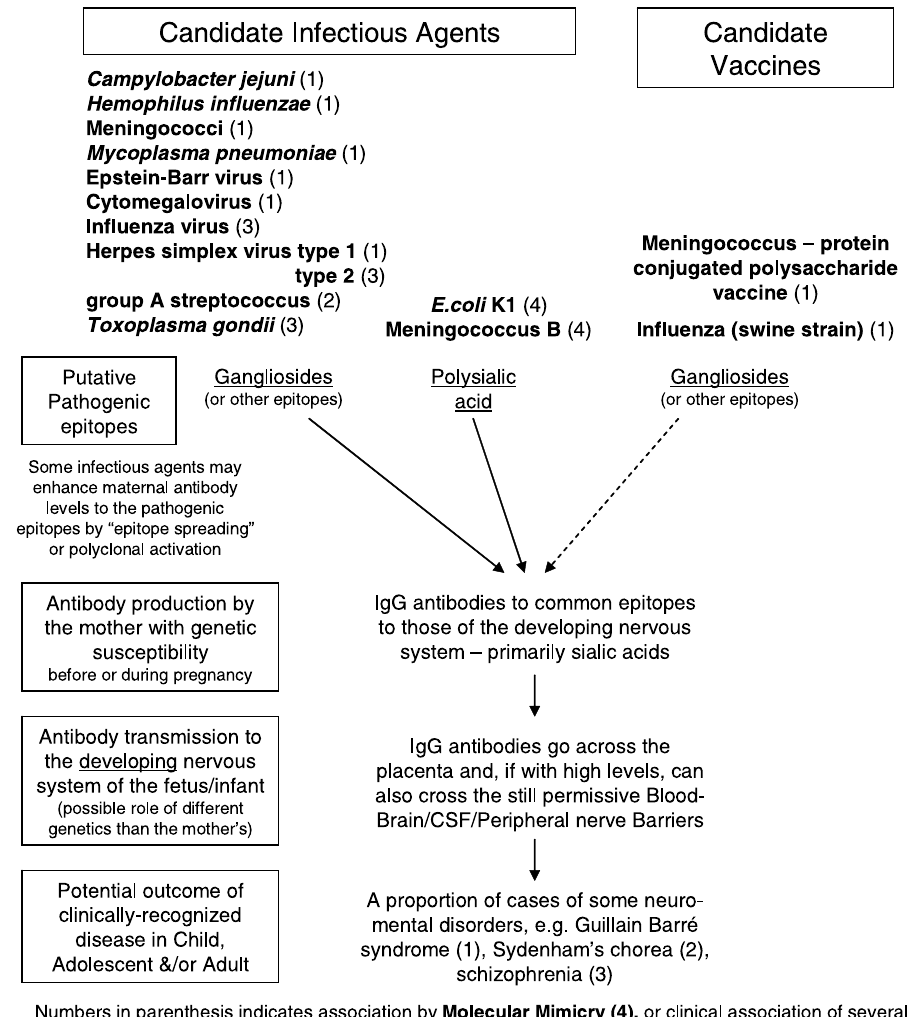
Figure 2. A more detailed version of the GENIP Hypothesis, listing candidate infectious agents and vaccines, and pathways from mother to fetus/infant, leading to NMD in later life. The rationale for selection of the candidate factors, detailed in the text, is based on molecular mimicry, (and/or) their association with various NMD in newborns and older